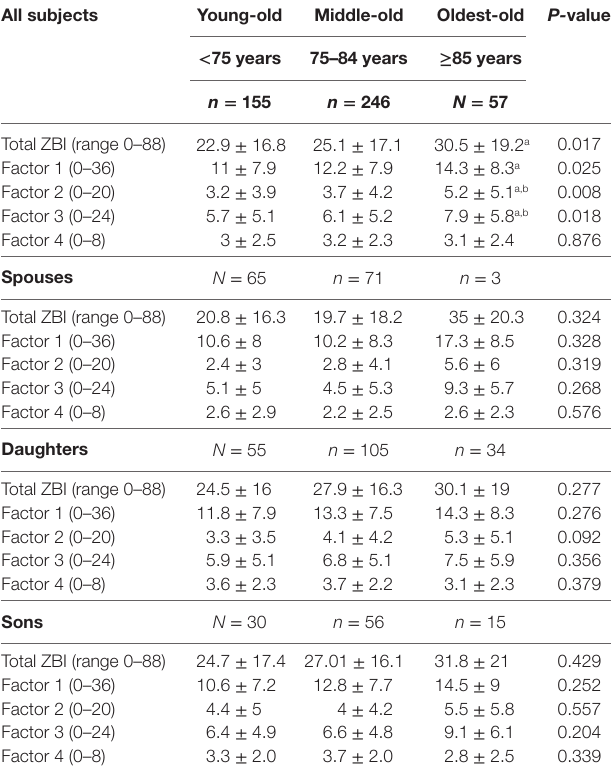
TaBle 4 | Comparison of Zarit Burden Interview (ZBI) total and factor scores across the three age groups stratified by relationship. all